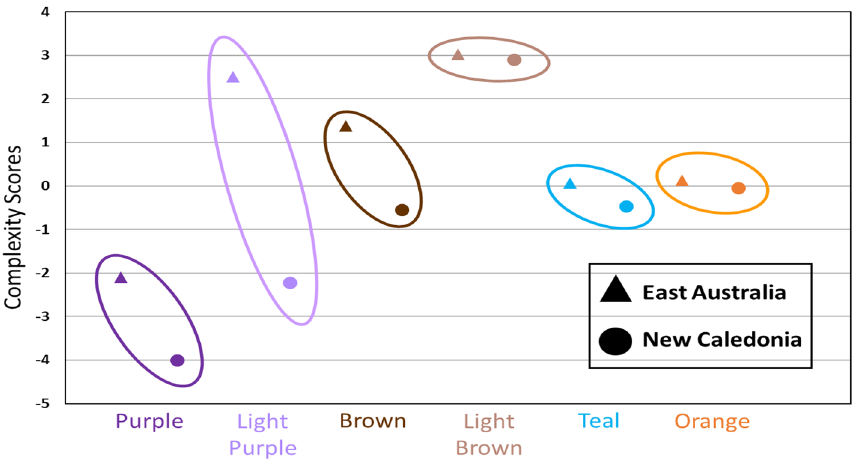
Figure 2. Complexity scores were calculated for each song type. Scores were calculated for each population using three variables at the song level (average total units, average unique units, average song length) and three variables at the theme level (average number of themes, average phrase length, average theme